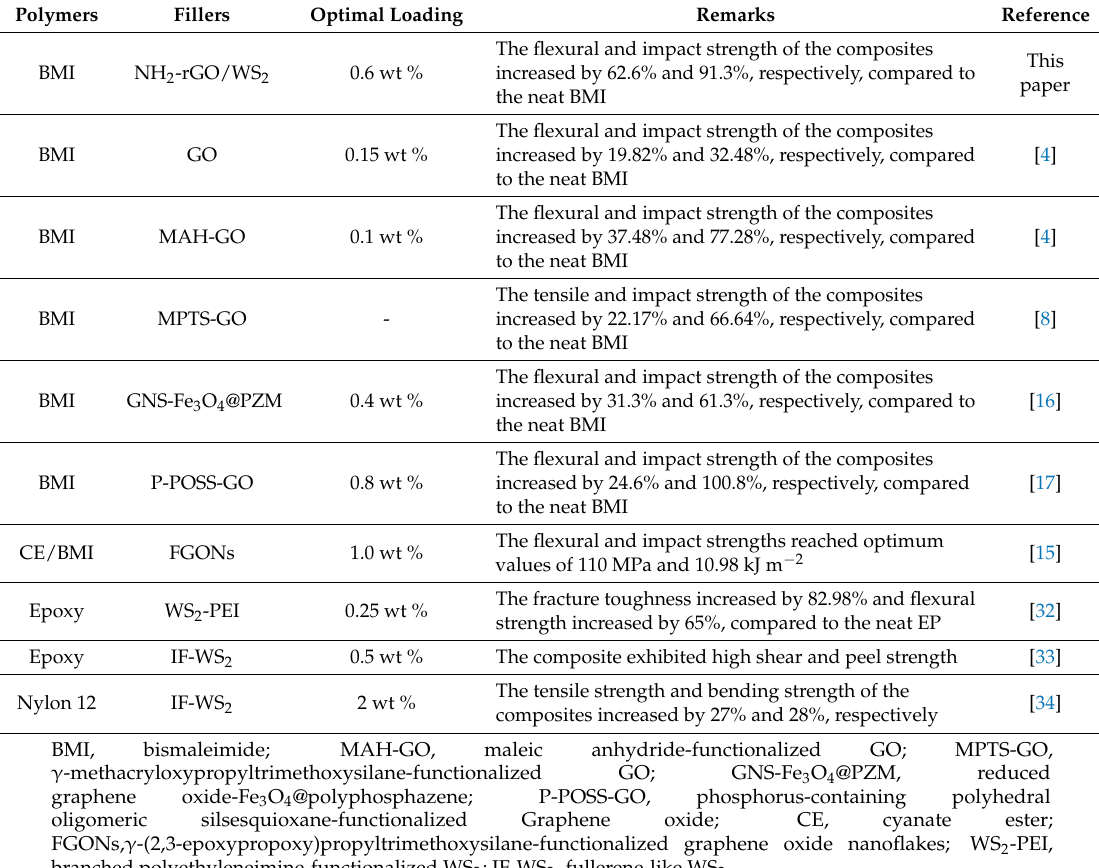
Table 1. Mechanical properties of bismaleimide and other polymer composite with different fillers. Polymers Fillers